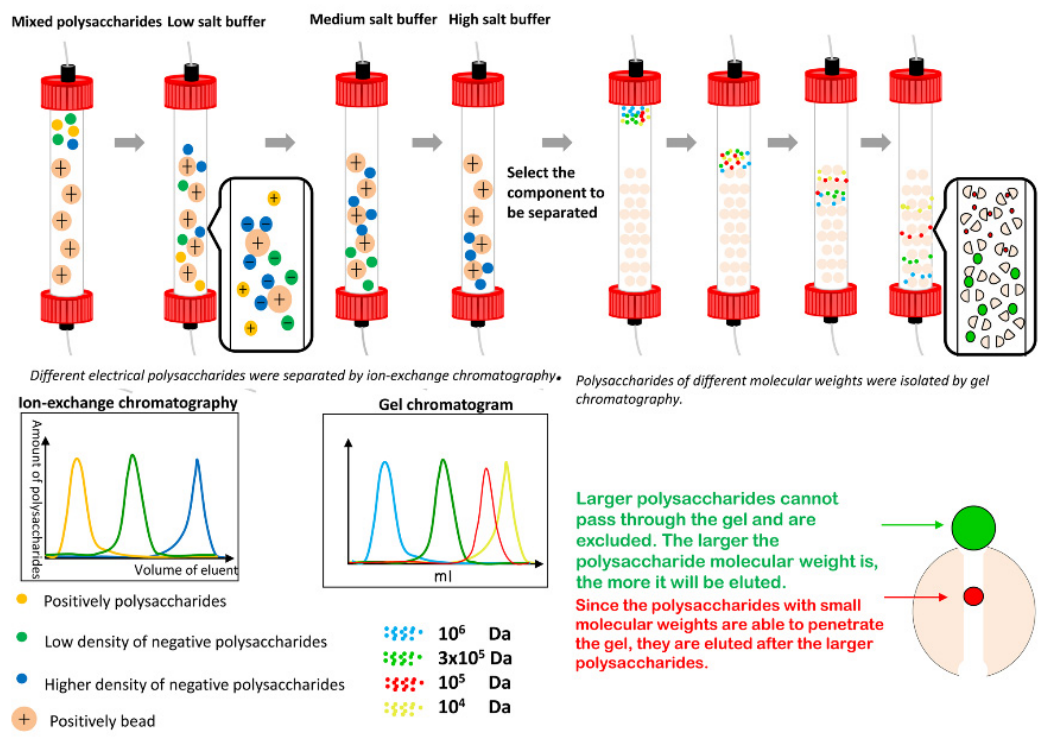
Figure 4. Schematic diagram of ion exchange and gel column chromatography.